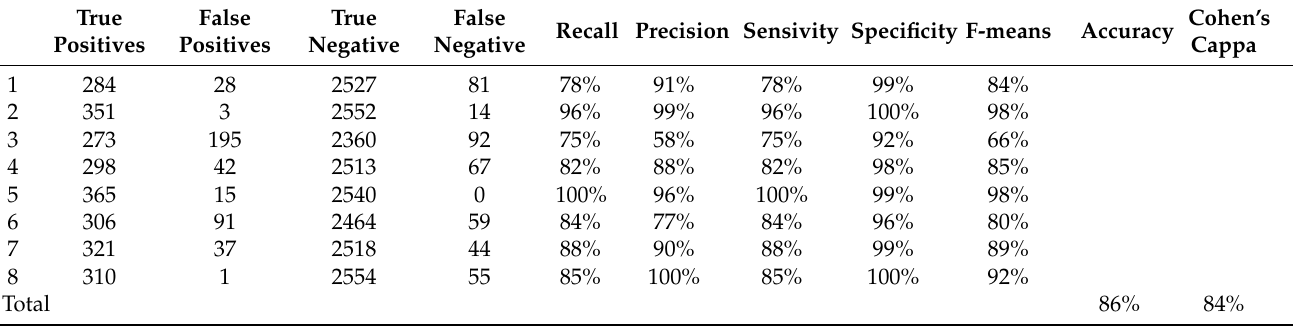
Table A3. The activity classification results for sensor s 4 .